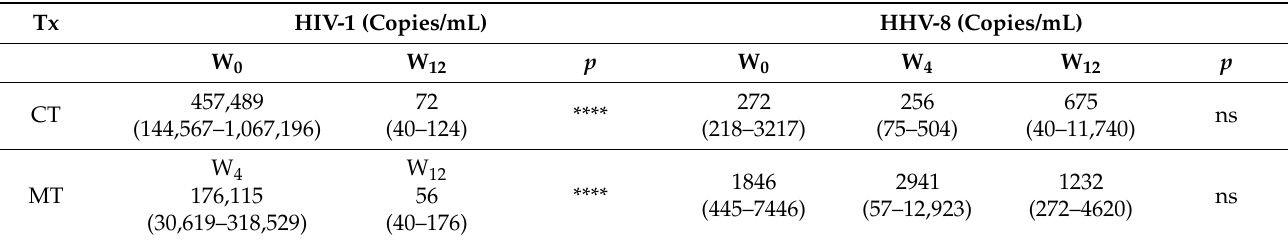
Table 2. Viral loads of HIV-1 and HHV-8 in KS/HIV patients.